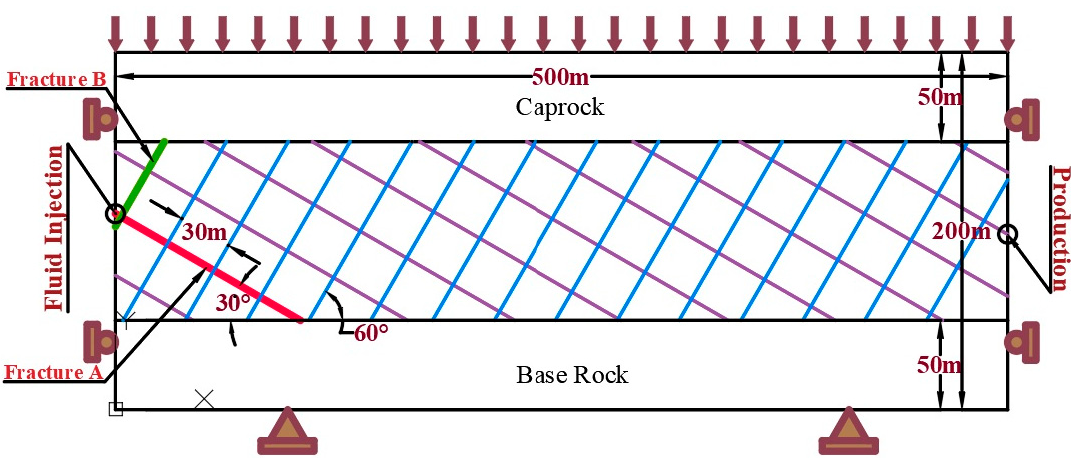
Figure 1. Schematic description of the model geometry and boundary conditions.